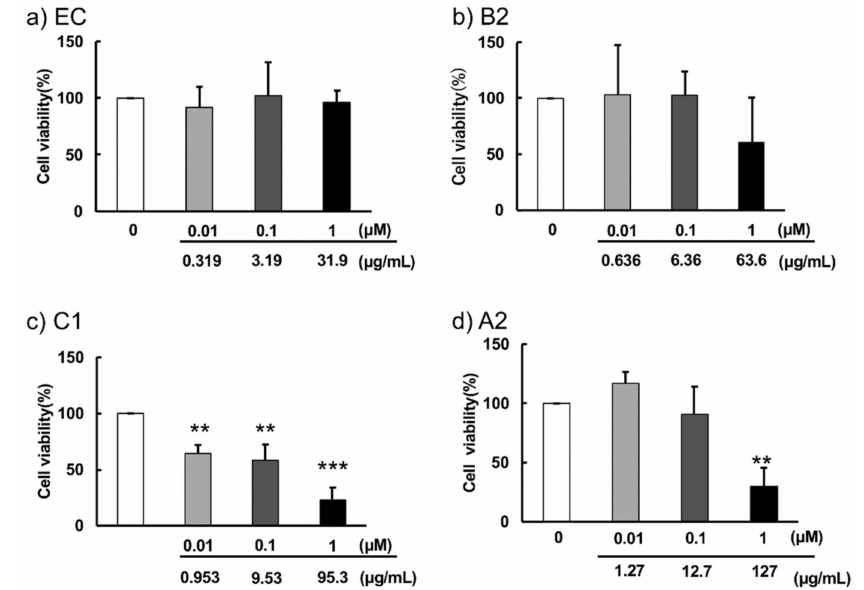
Figure 5. F10 cell viability 48 h after incubation in the presence of di ff erent concentrations of EC ( a ), B2 ( b ), C1 ( c ) or A2 ( d ) in control culture medium supplemented with 2% NutriStem V9 XF Basal Medium (XF). Each value represents mean ± SD ( n = 5). Significant di ff erences vs. no addition (0 µ g / mL): ** p < 0.01, *** p <